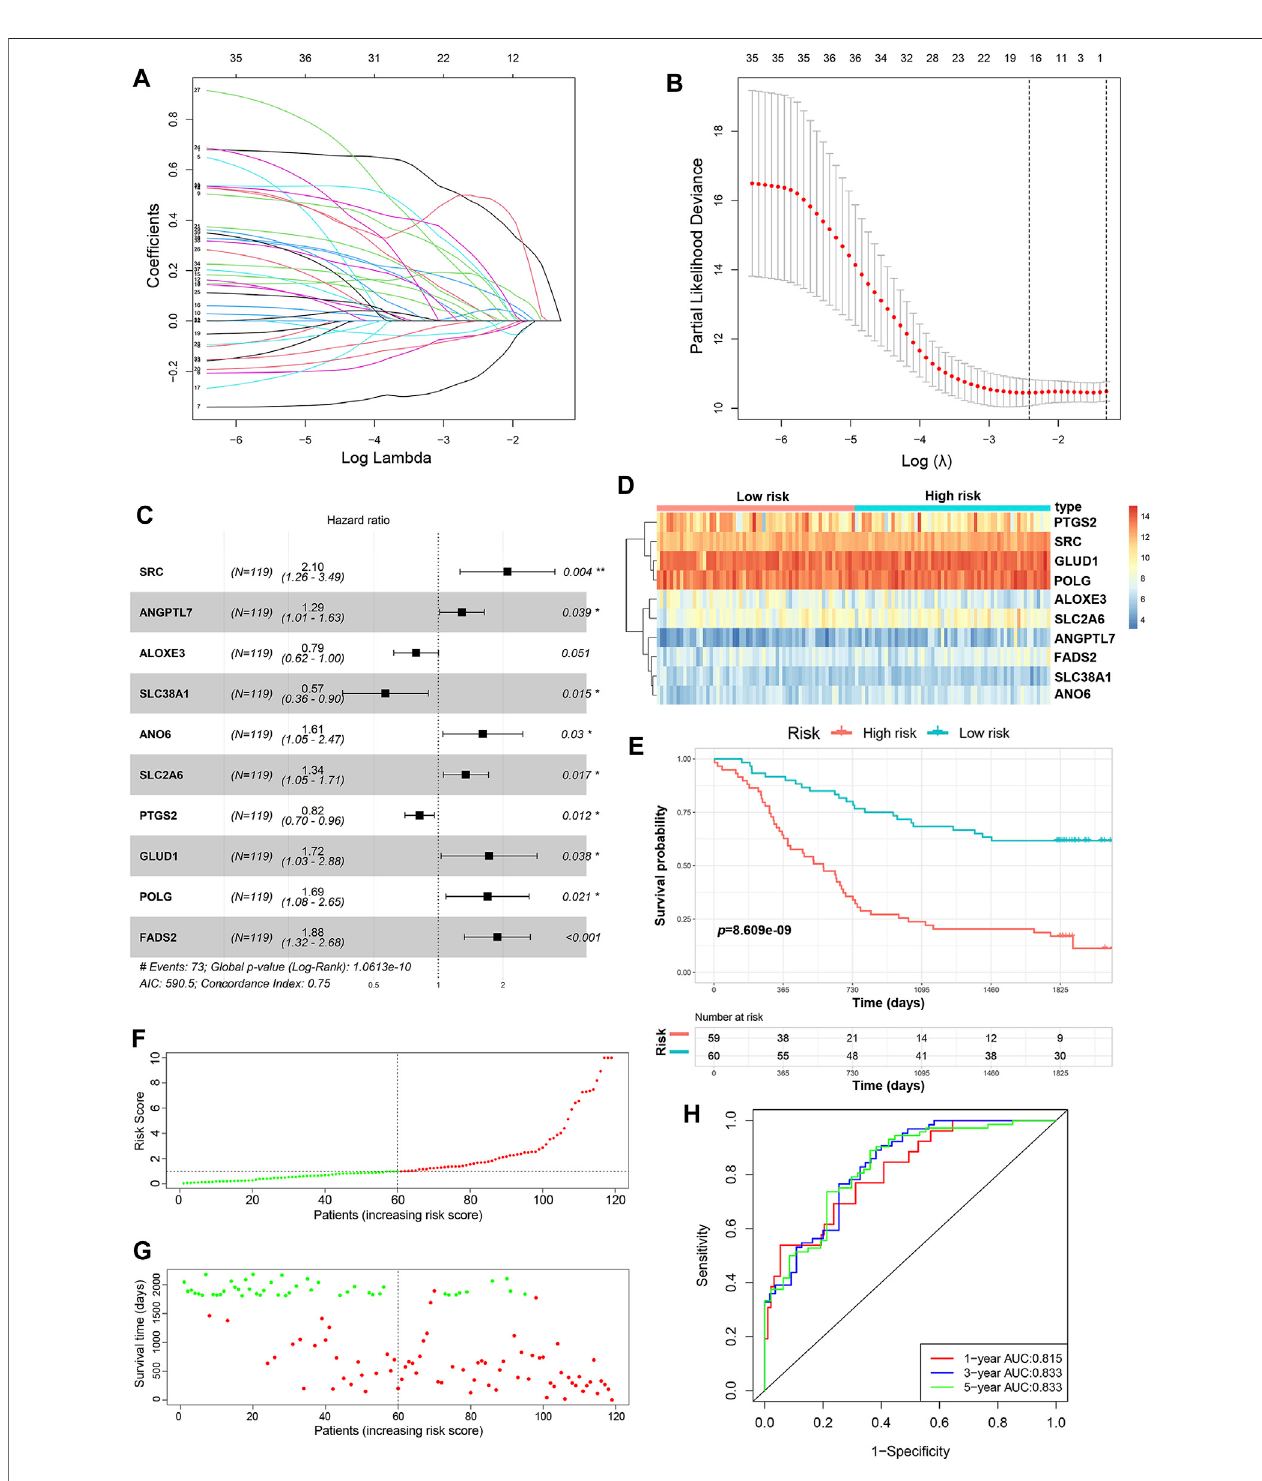
FIGURE 2 | Construction of the predictive risk model based on the FRG signature. (A,B) LASSO regression was performed to select the optimal value of λ . (C) Forest plots showing the signi fi cantly prognostic FRGs based on the results of multivariate Cox regression. (D) The heatmap displays the expression pro fi le of the ten FRGs from the GSE53624 dataset. (E) Kaplan-Meier survival curves show the OS of patients in the GSE53624 dataset. (F) The distribution and median value of the risk score in the GSE53624 dataset (red: high-risk; green: low-risk). (G ) Survival status plots of patients in the GSE53624 dataset (red: death; green: survival). (H) ROC curves of the risk model for predicting the 1-, 3- and 5-years OS of patients in the GSE53624 dataset.